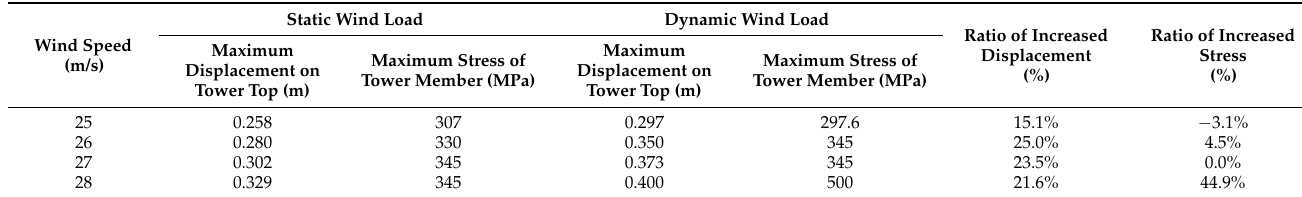
Table 6. Comparison of wind-induced response of transmission tower under static and dynamic wind